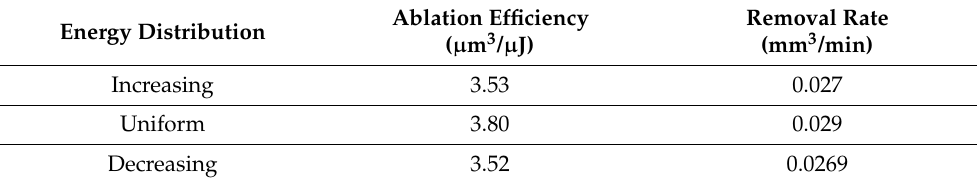
Table A7. Ablation efficiencies and removal rates of brass.